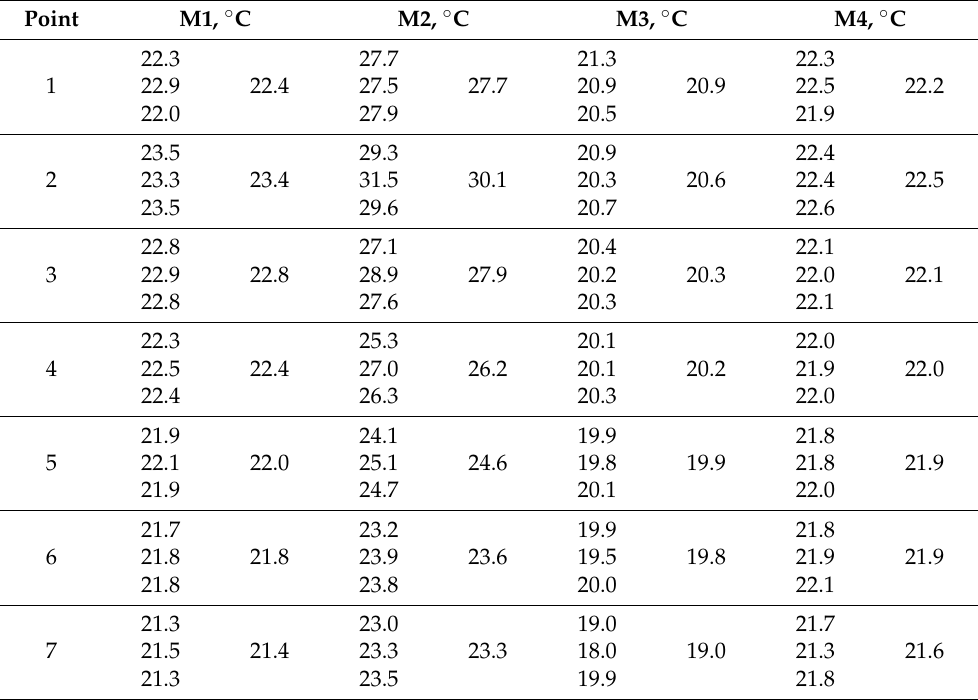
Table 3. The temperature distribution on the front side of briquette surfaces in the characteristic points.